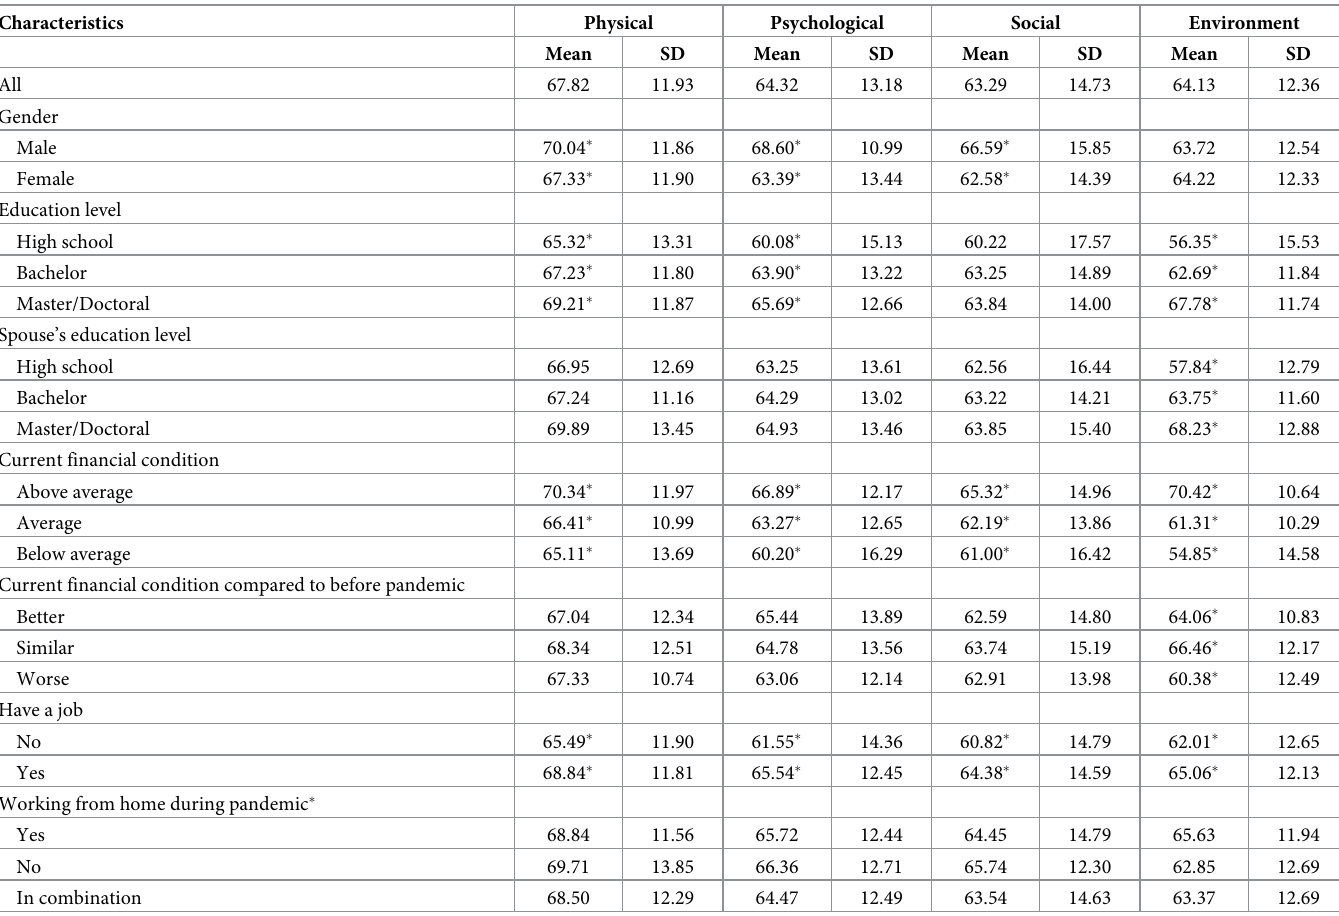
Table 2. Mean scores and standard deviation (SD) of quality of life domains in the total population sample and sub-samples by socio-demographic characteristics.